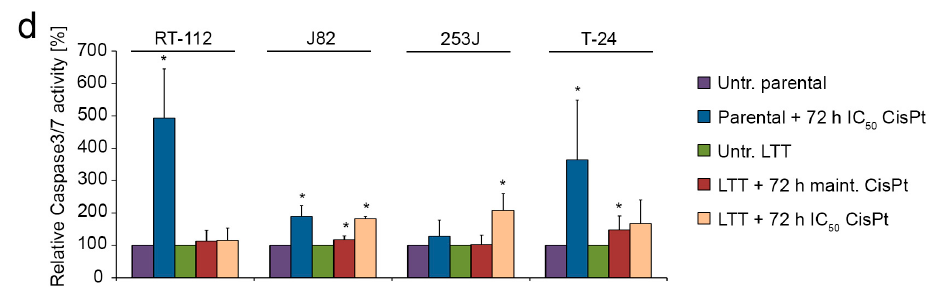
Figure 4. LTTs are more resistant to induction of cisplatin-induced apoptosis. ( a ) Relative fold change of BCL2 , BCL-xL , BCL-xS , and BIRC5 /Survivin mRNA expression in LTTs compared to their parental cell lines was measured by qRT-PCR. Expression levels in the untreated parental cells were set as 1. For endogenous expression data of parental UCCs see Figure S1d. SDHA was used as a reference gene and relative expression was calculated by the 2 −ΔΔ C t method. Values represent the mean ± SD of three independent experiments. BIRC5/Survivin, BCL-xL, BCL-xS ( b ), PARP, cleaved PARP, Caspase-3, and cleaved Caspase-3 ( c ) protein expression was detected in either untreated or IC 50 doses treated parental UCCs and compared with LTTs under either untreated conditions or treated with maintenance or IC 50 cisplatin concentration for 72 h. As a loading control, α -Tubulin was detected. One representative immunoblot is shown from two independent experiments. ( d ) Caspase 3/7 activity was measured in parental UCCs untreated or treated with IC 50 cisplatin concentration and LTTs treated with maintenance or IC 50 cisplatin concentration for 72 h. Values were adjusted to cell viability as measured by CellTiter Glo. Values represent the mean ± SD of two independent experiments. * p < 0.05.